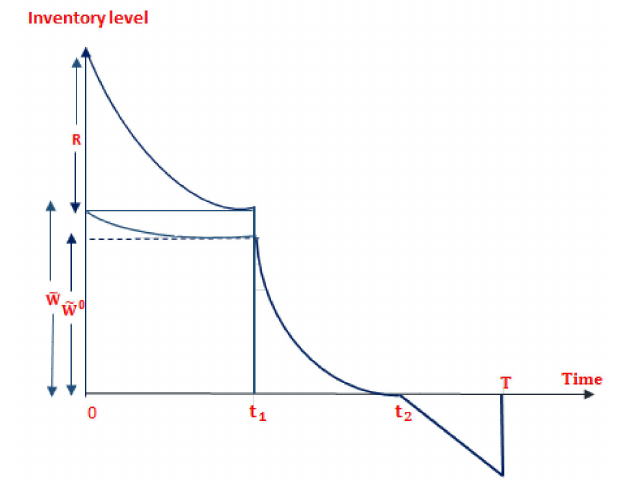
Figure 4. Concept of LIFO policy depicted visually.